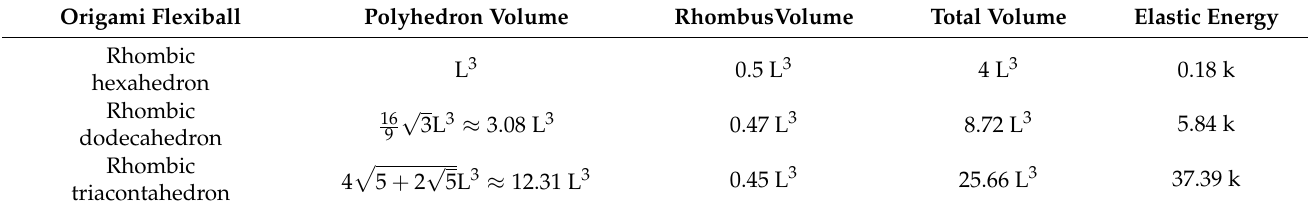
Table 3. Volumes and elastic energies of origami